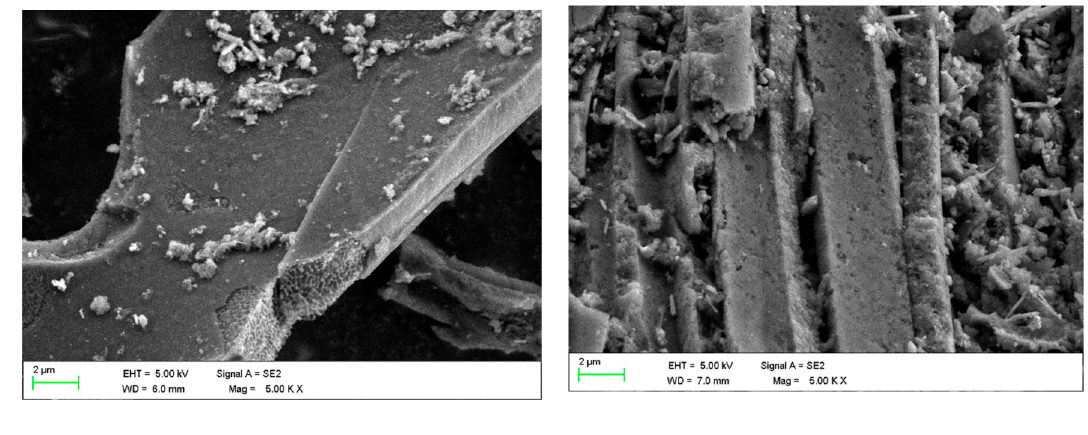
Figure 4. FE-SEM pictures of ( a )Virgin-C and ( b ) SLS-C.